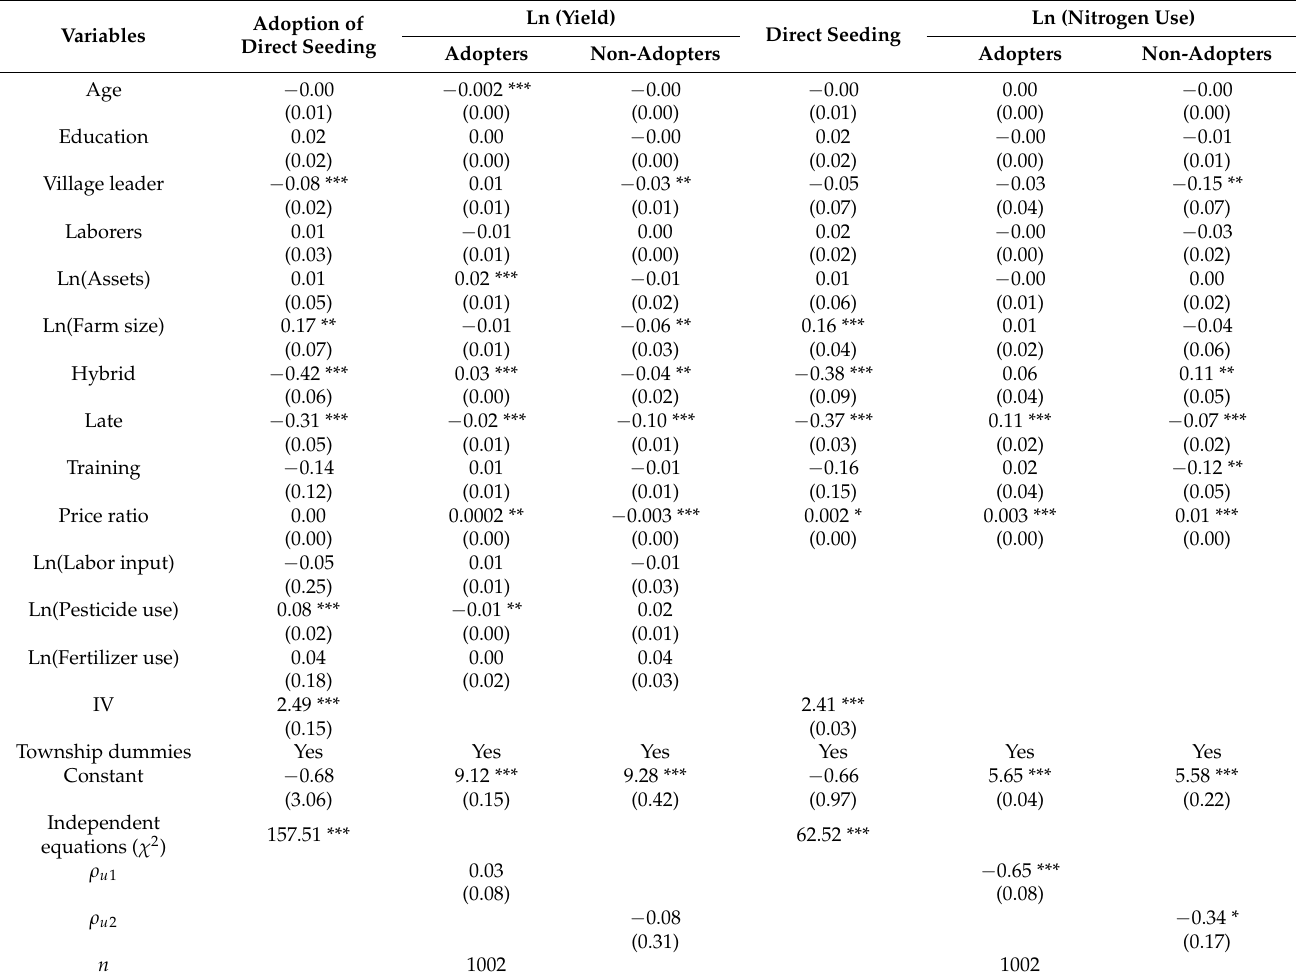
Table 6. Estimated results for the robustness